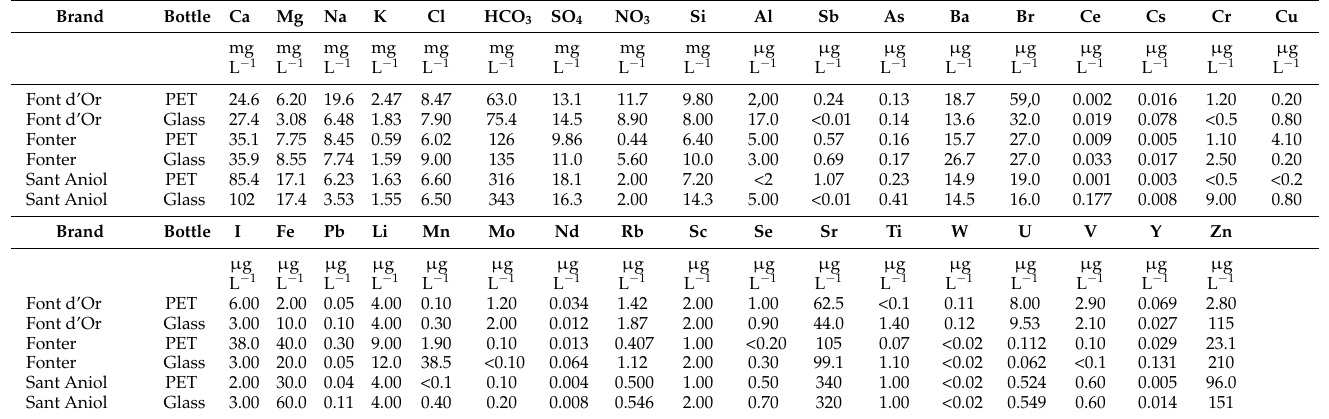
Table 4. Comparison between 3 water samples bottled in glass and